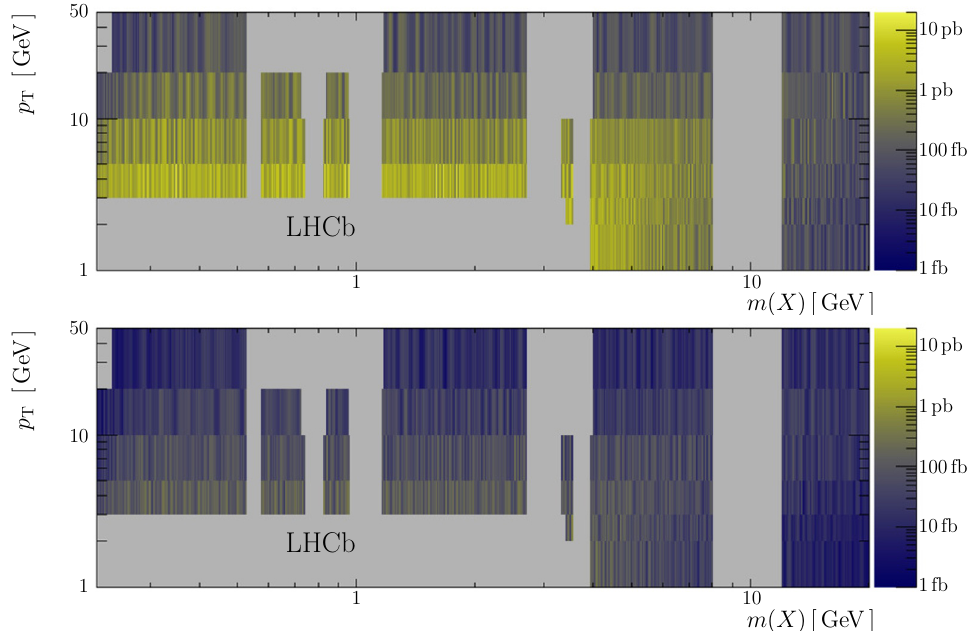
Figure 7 . Upper limits at 90% con(cid:12)dence level on the cross section (cid:27) ( X m ( X ) < 20 GeV region for the (top) inclusive and (bottom) associated beauty searches for prompt X (cid:22) + (cid:22) (cid:0) decays. !